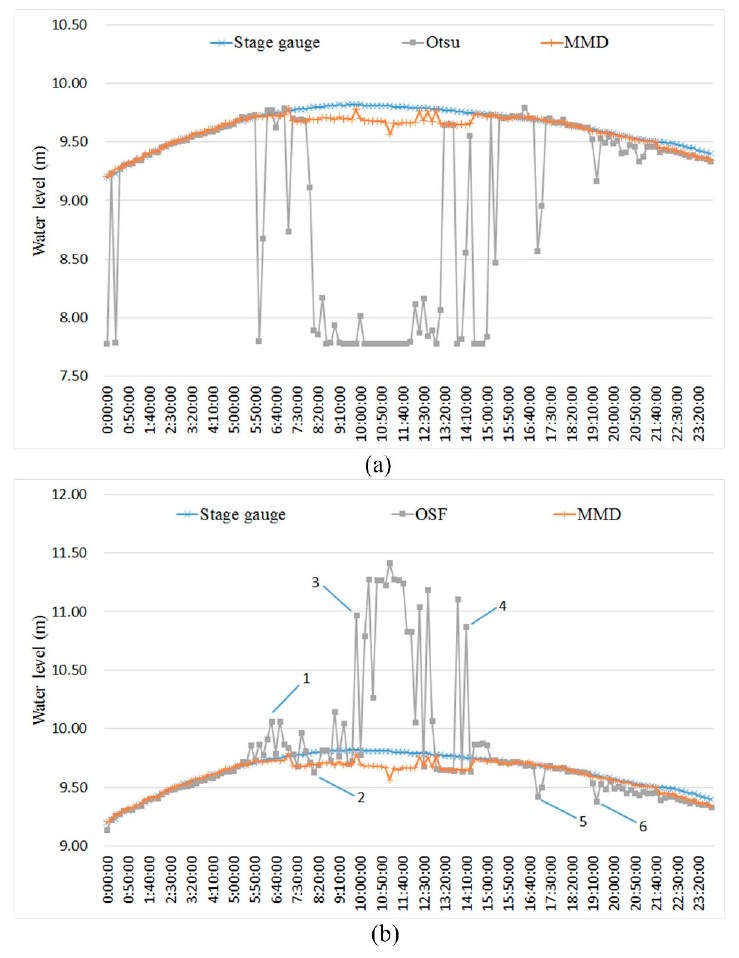
Figure 11. Water-level measurement results: ( a ) comparison results of Otsu and MMD methods; ( b ) comparison results of the order-statistic filtering (OSF) and MMD methods. Table 2. Root mean square errors (RMSEs) and error measurements of Otsu, OSF and MMD